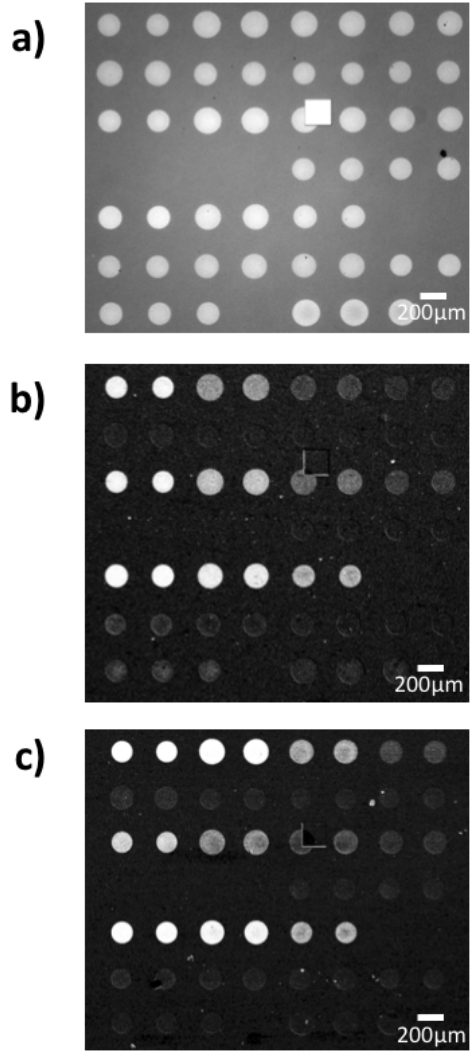
Figure 3. Interferometric Reflectance Imaging Sensor (IRIS) images of the chips utilized for the experiment ( a ) before incubation and differential images after incubation with ( b ) antibodies and ( c ) small EVs. Note that a similar level of signal does not necessarily correspond to the same increase in thickness, since the antibody experiment was carried out with blue LED illumination (452 nm) while the exosome capture was performed with green LED illumination (512 nm), to ensure a proper correlation between signal and